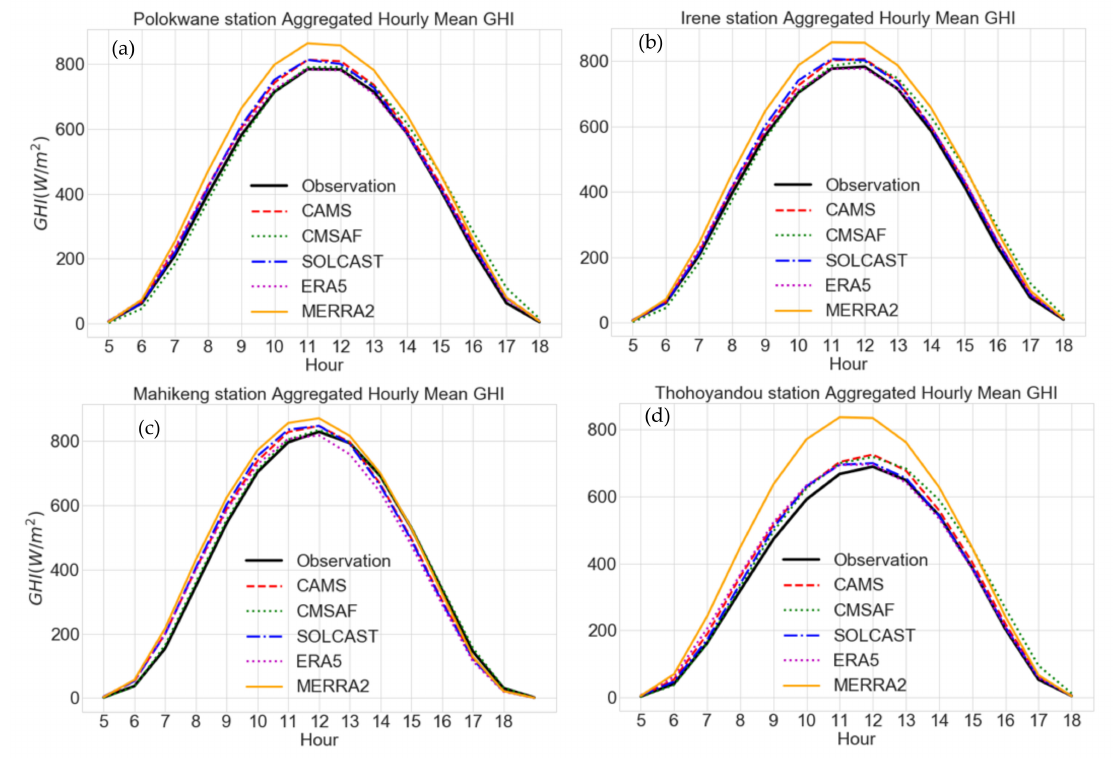
Figure 7. Aggregated measured and estimated hourly GHI values in Polokwane ( a ), Irene ( b ), Mahikeng ( c ), and Thohoyan- dou ( d ). The aggregated GHI Observation period for each station is given in Table 2.